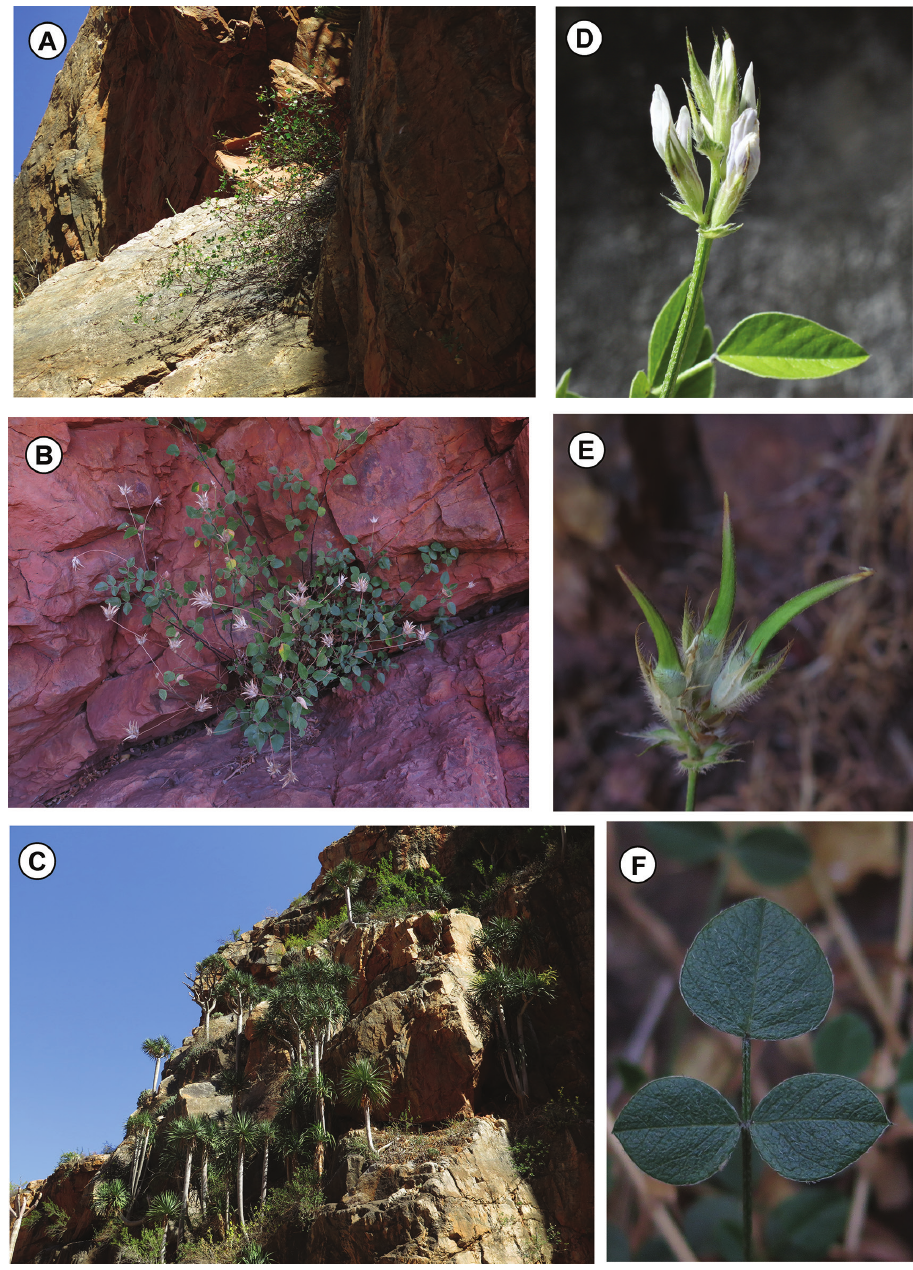
Figure 4. Phenological features of Bituminaria antiatlantica A Natural habitat with Bituminaria antiat- lantica in Djebel Imzi (Morocco) B Habit of B. antiatlantica in Mount Tachilla (Morocco) C Natural habitat of B. antiatlantica with Dracaena draco L. subsp. ajgal in Djebel Imzi (Morocco) D Inflorescence detail of B. antiatlantica E Fructified inflorescence of B. antiatlantica F Leaf detail of B. antiatlantica (Photos by S.